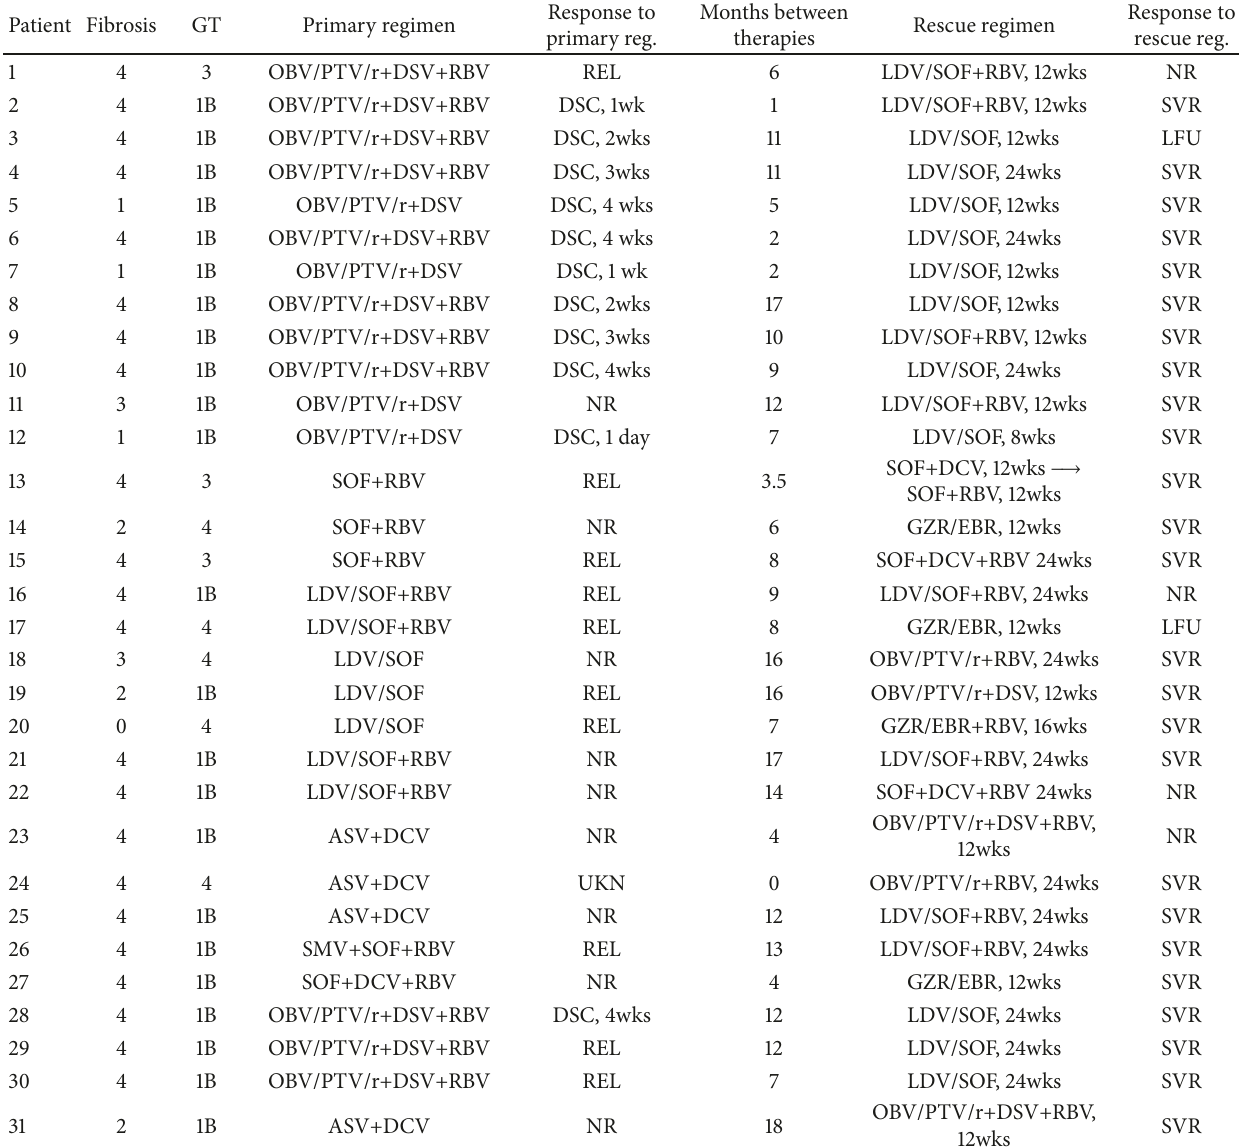
Table 3: Individual efficacy data depending on HCV genotype, hepatic fibrosis, and primary and rescue regimen. Patient Fibrosis GT Primary regimen